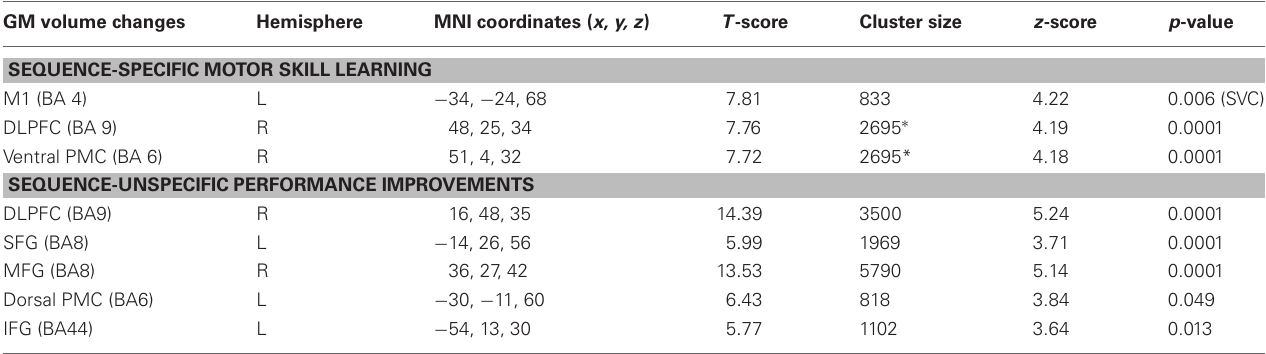
Table 1 | Positive correlation between GM volume changes and (A) sequence-specific motor skill learning in a SPFT as well as (B) sequence-unspecific performance improvements (day 5 vs. day 1 [%]).